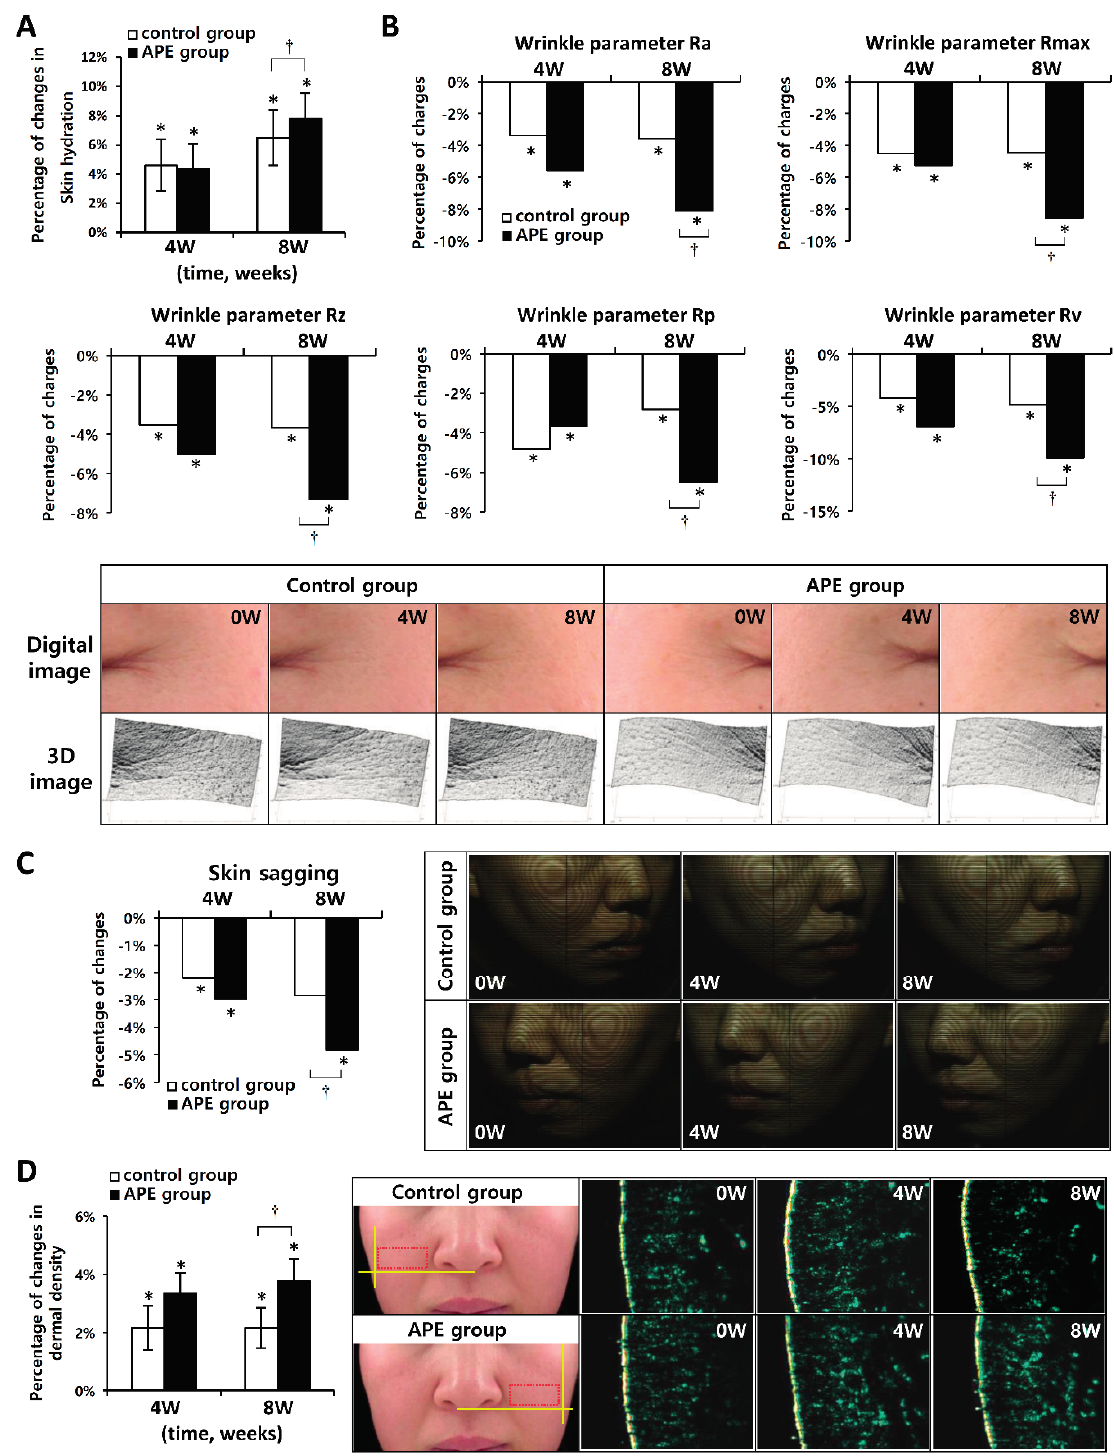
Figure 5. Clinical trial changes in skin hydration, wrinkling, sagging and dermal density, following eight consecutive weeks of test product application, respectively, were observed and monitored. ( A ) Skin hydration was detected using a capacitance method; ( B ) The decrement rate of the wrinkle parameters: Ra, Rmax, Rz, Rv, Rp. Digital and 3D imaging indicated a difference in wrinkle values; ( C ) Skin sagging was detected using contour line imaging and the decrement rate; ( D ) A dermal density analysis was confirmed using an ultrasonic system. Mean ± SEM. * p < 0.05 vs . before treatment, † p < 0.05 vs. Control